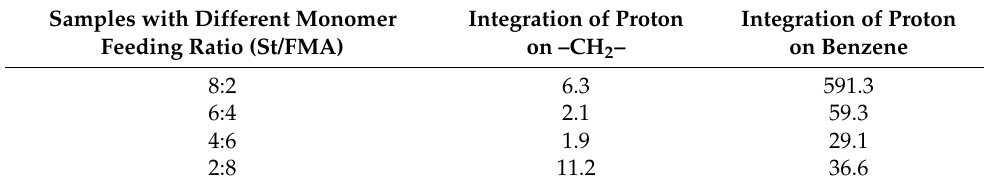
Table 1. Integration of proton on -CH 2 - or benzene groups in copolymers with different monomer feeding